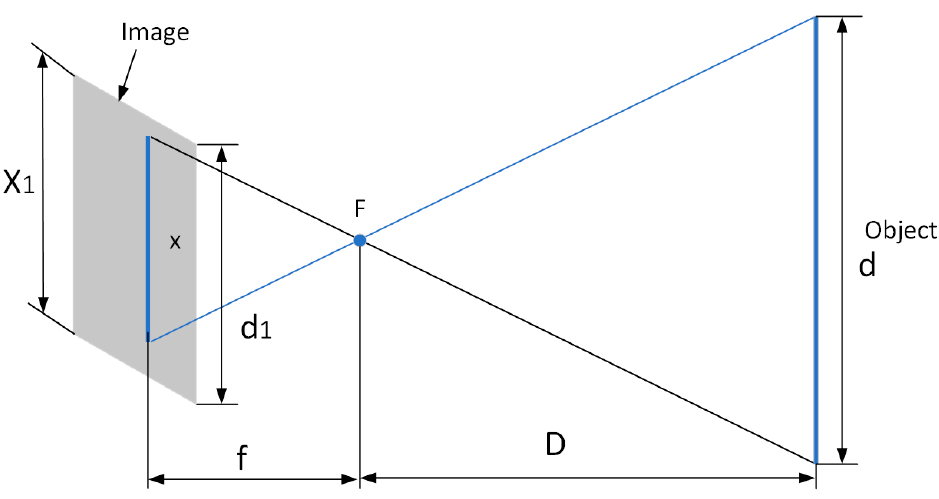
Figure 9. Camera imaging